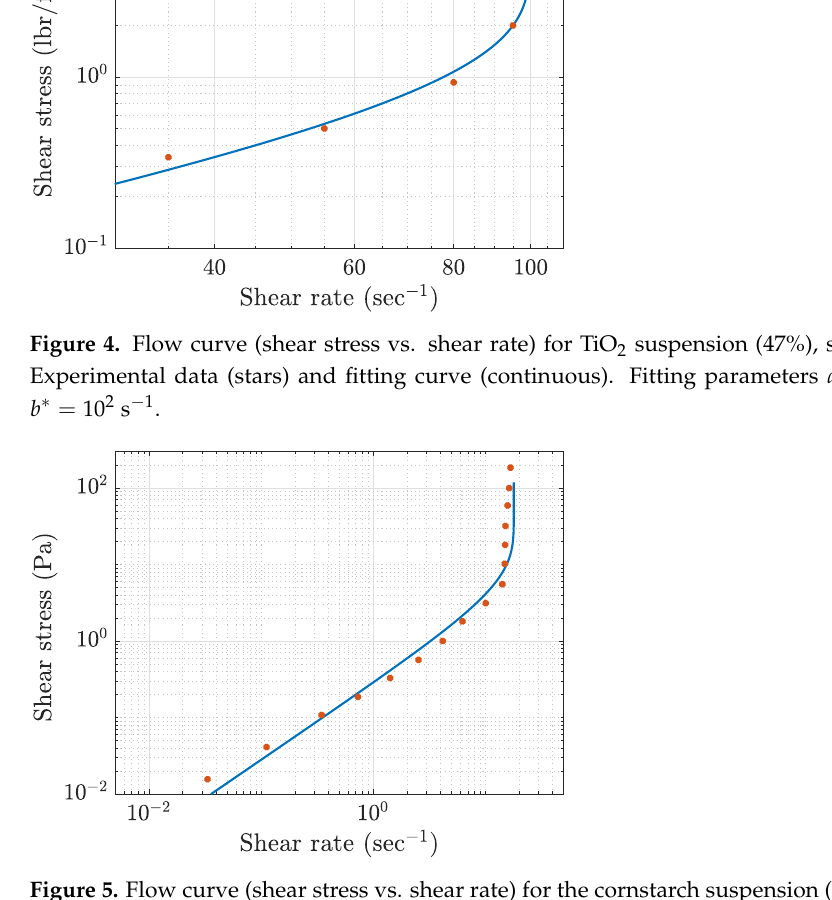
Figure 5. Flow curve (shear stress vs. shear rate) for the cornstarch suspension (50%), see Figure 1 in [16]. Experimental data (stars) and fitting curve (continuous). Fitting parameters a ∗ = 0.2 (Pa − 1 ), b ∗ = 18 s − 1